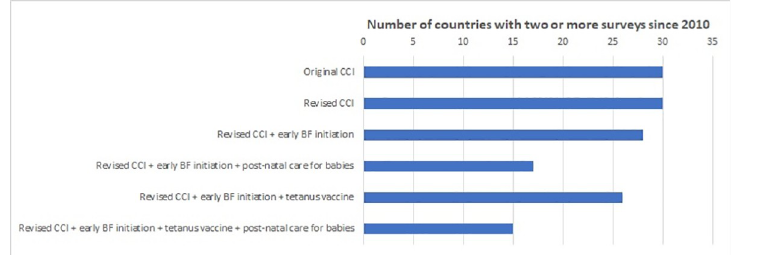
Fig 3. Information availability for time trend analysis for each CCI